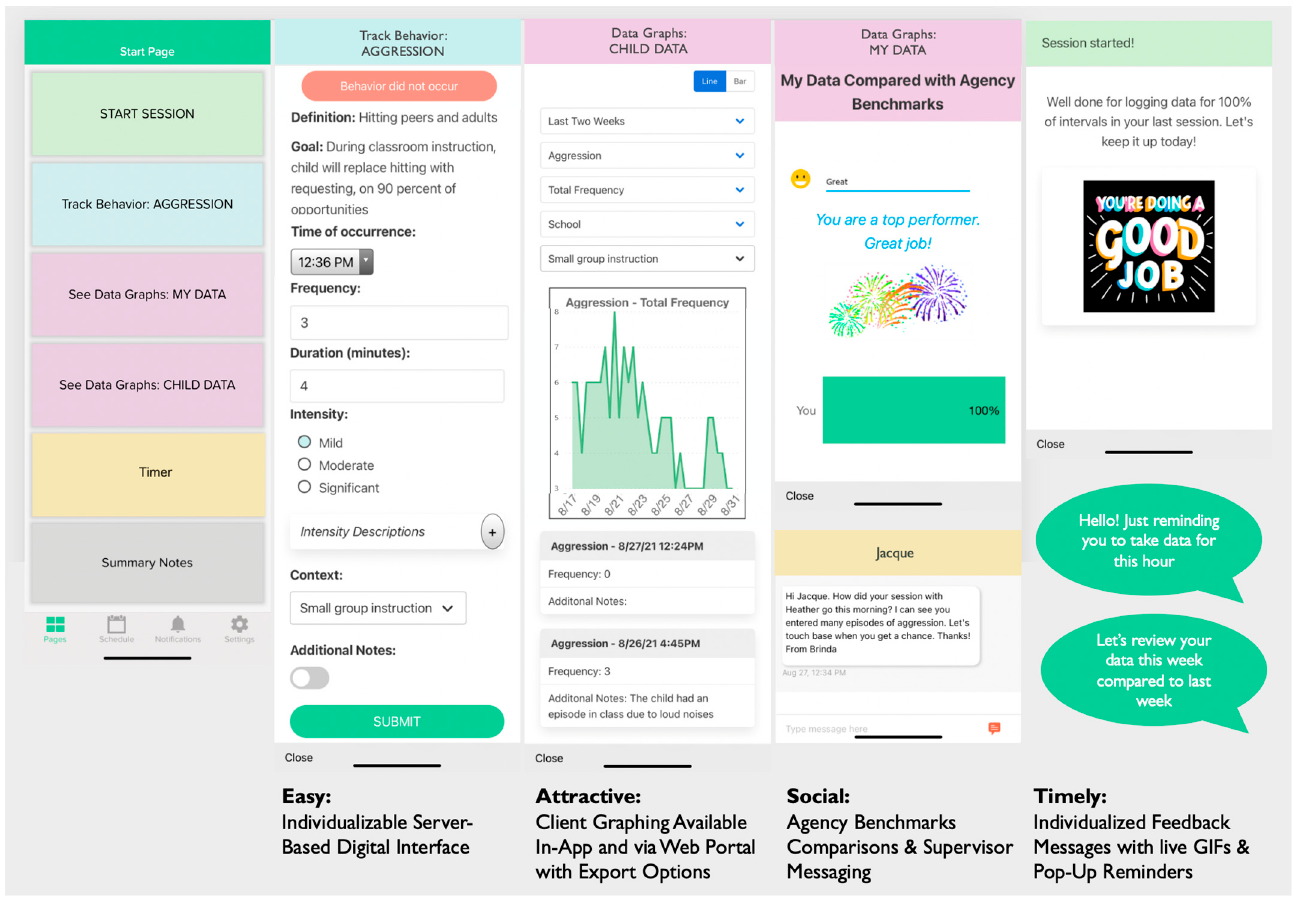
Figure 2. App Design Incorporating Behavioral Economics EAST * (Easy, Attractive, Social and Timely) Principles. * https://www.bi.team/publications/east-four-simple-ways-to-apply-behavioural-insights/ (accessed on 1 September Table 2. Footsteps app: basic data collection and behavioral economics features.